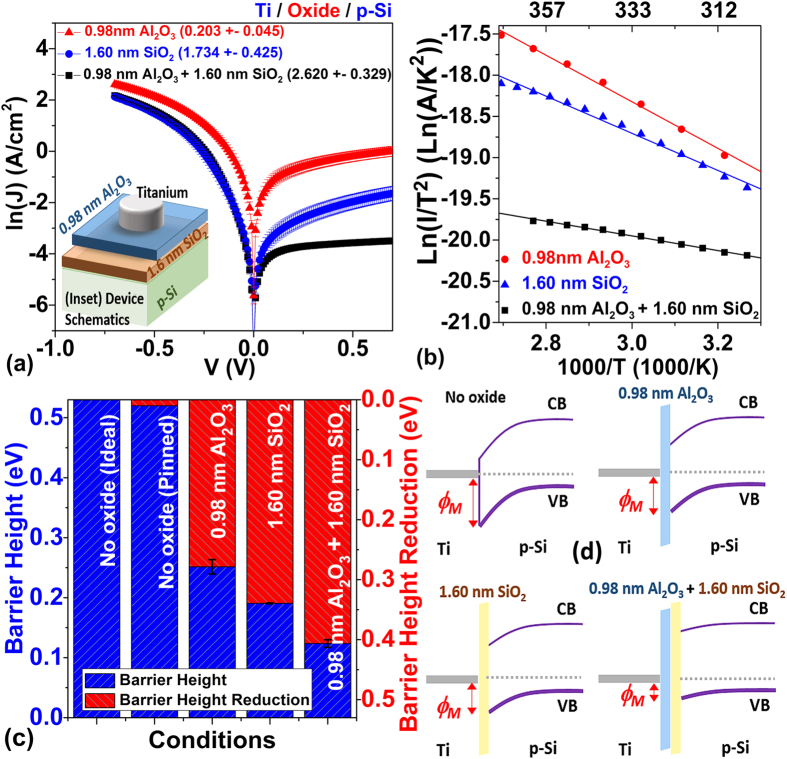
Comparison of Ti-p Si contact with different thickness/type of dielectrics (a) Ln(J)-V characteristics. The brackets give the specific contact resistivity. Inset: Schematics of device structures; (b) the Richardson plots; (c) the barrier heights; (d) schematics of energy band diagram showing the barrier reduction of Ti-p Si contact by insertion of thin dielectrics.